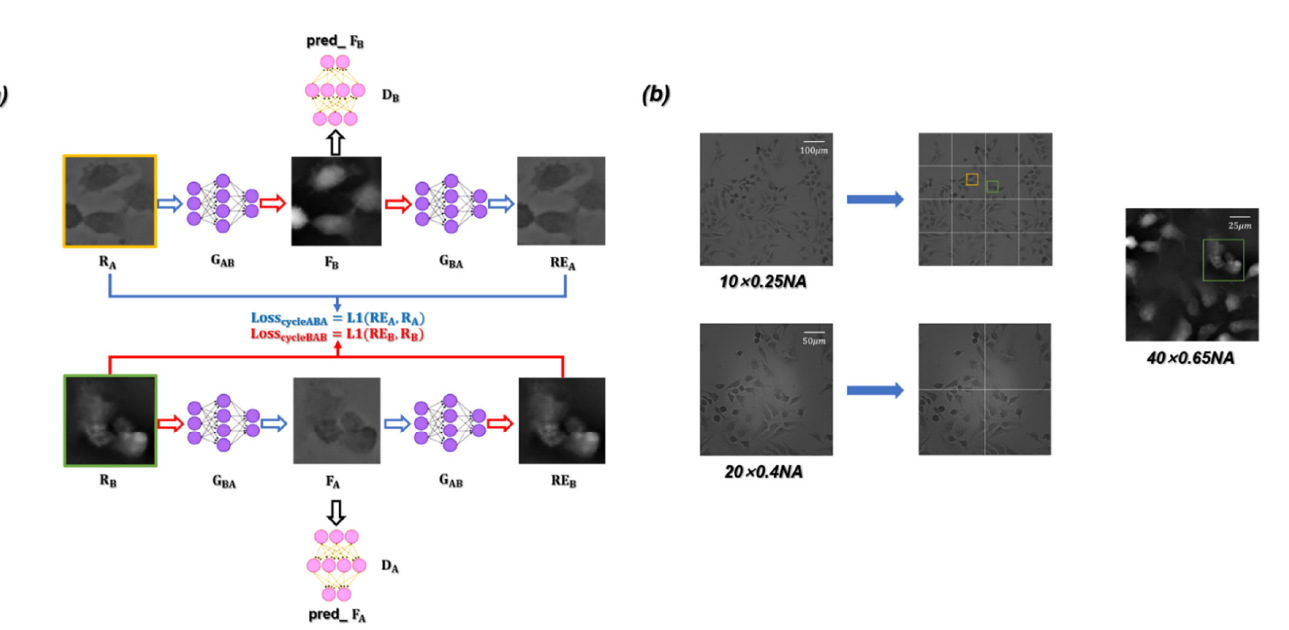
Figure 2. ( a ) Training flow diagram. ( b ) By segmenting the LR microscopic images with different resolutions, the sub-images with an FOV approximately equal to the HR quantitative phase images are obtained for training the ContransGAN. Orange and green rectangles are Region of Interest (ROI).